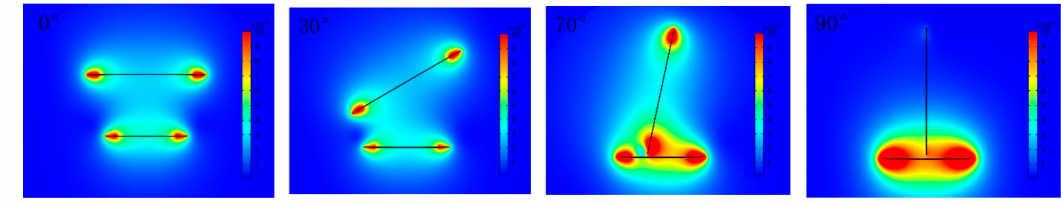
Figure 11. Magnetic flux density with di ff erent angular deviations in asymmetrical system.